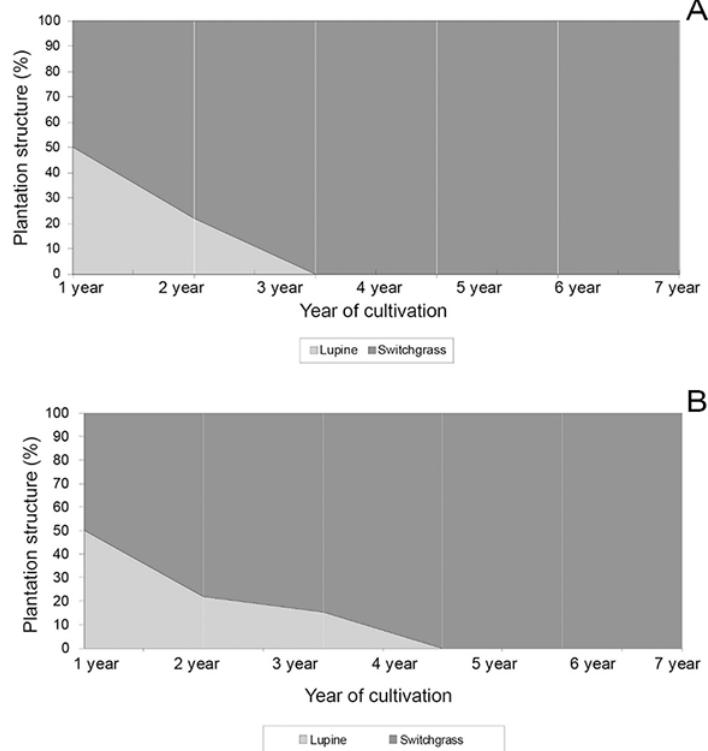
Fig. 4 Structure of energy plantations of switchgrass with lupine: in Sw|L ( A ) and in Sw:L ( B ), between